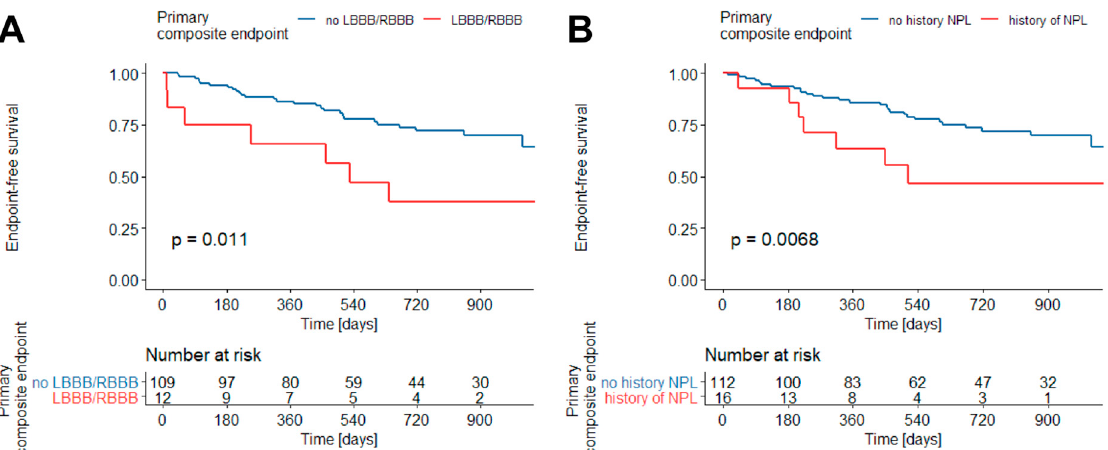
Figure 2. Primary composite endpoint free survival in patients with MINOCA and RBBB/LBBB in ECG on discharge ( A ) and history of neoplasm ( B ) (Kaplan–Meier estimator). Abbreviations: RBBB—right bundle branch block, LBBB—left bundle branch block, NPL—neoplasm.